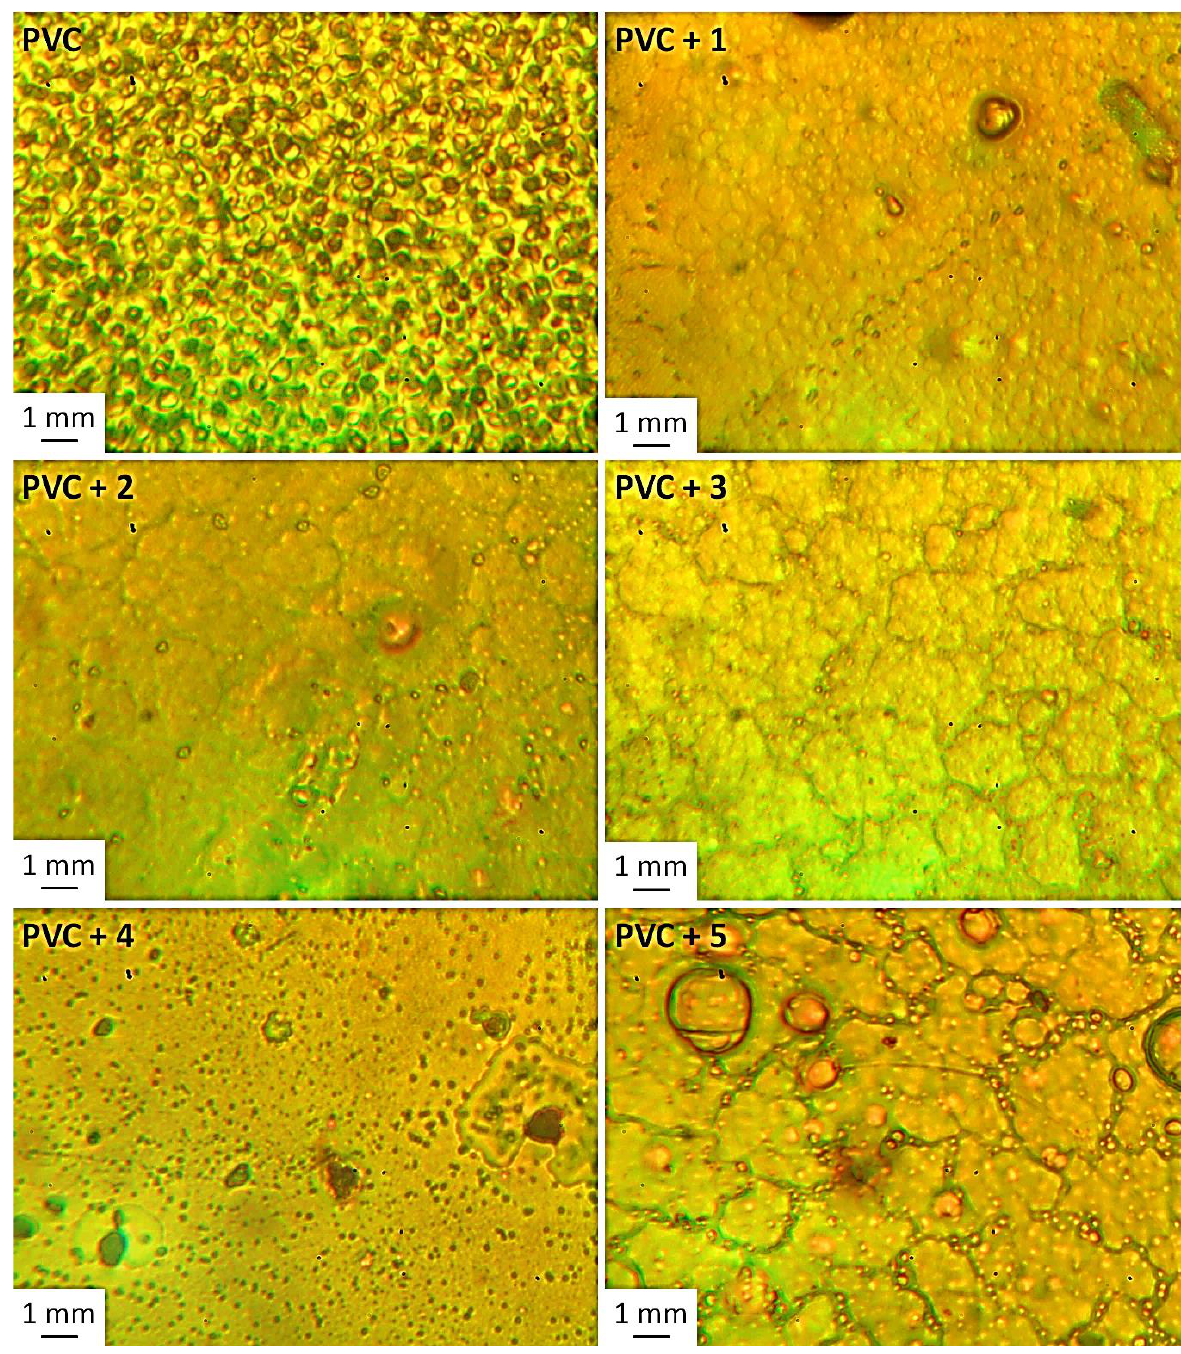
Figure 9. Images under the optical microscope for the irradiated PVC films.